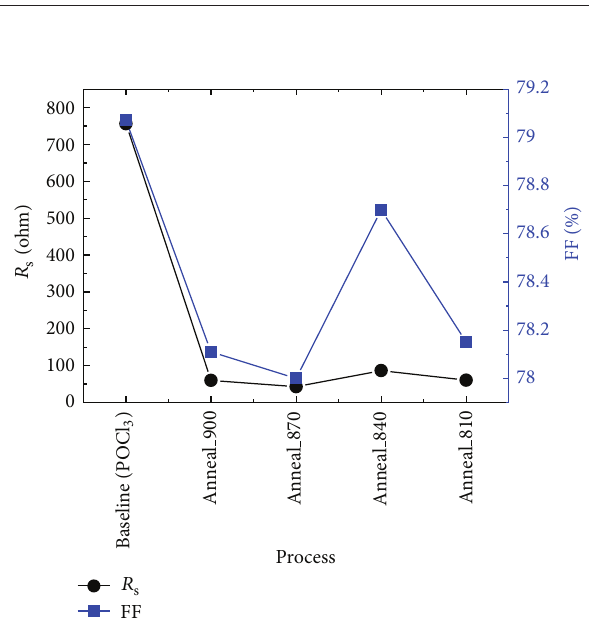
Figure 9: 𝑅 and FF for the POCl 3 diffusion and implantation shunt processes.